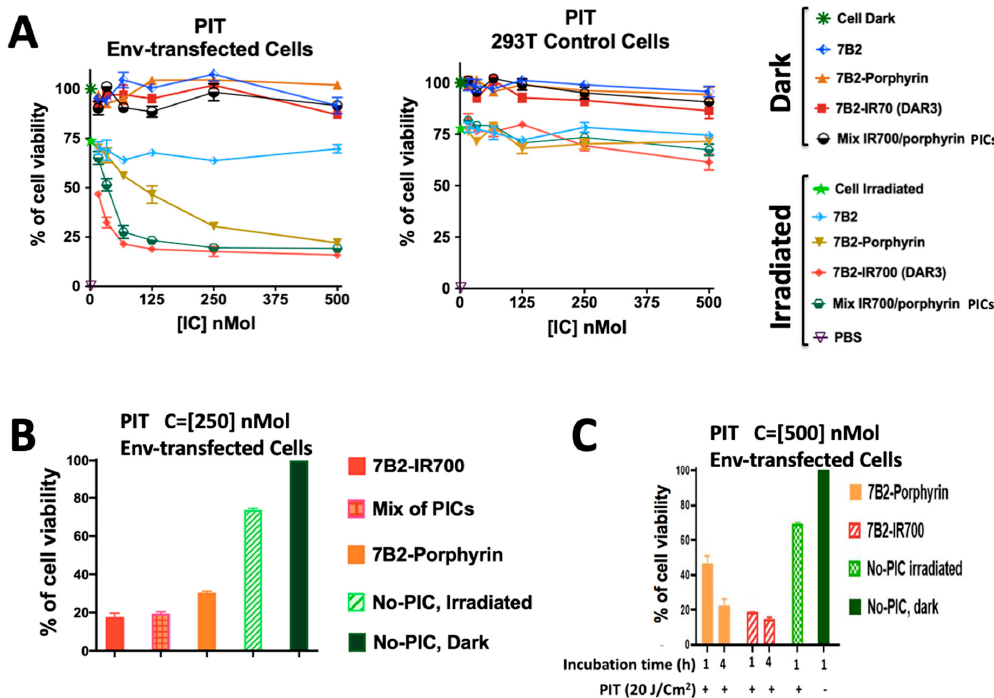
Figure 5. Comparing the photo-cytotoxicity and targeting of PICs by direct cytotoxicity assay. ( A ) Env-transfected 293T cells (293T / 92UG) and control 293T cells were incubated with 7B2-IR700 (DAR 3), 7B2-porphyrin and an equal molarity mixture of both PICs in the presence of sCD4 (anti-gp120) for 4 h then were assayed by PIT. Data are ± means S.E.M. ( n = 3 ) with three individual experiments. Where no error bars are visible, they are obscured by the symbol. ( B ) An equal molarity mixture of porphyrin-PIC with IR700-PIC may increase the cytotoxicity in compare to porphyrin-PIC or the average cytotoxicity of both PICs. Data are ± means S.E.M. ( n = 3 ). ( C ) Incubation of transfected cells in two di ff erent times (1 and 4 h) before PIT showed the internalization-dependency of Mab-porphyrin to have more photo-cytotoxicity, while the membrane binding of 7B2-IR700 was su ffi cient to induce cell death. Data are ± means S.E.M. ( n =